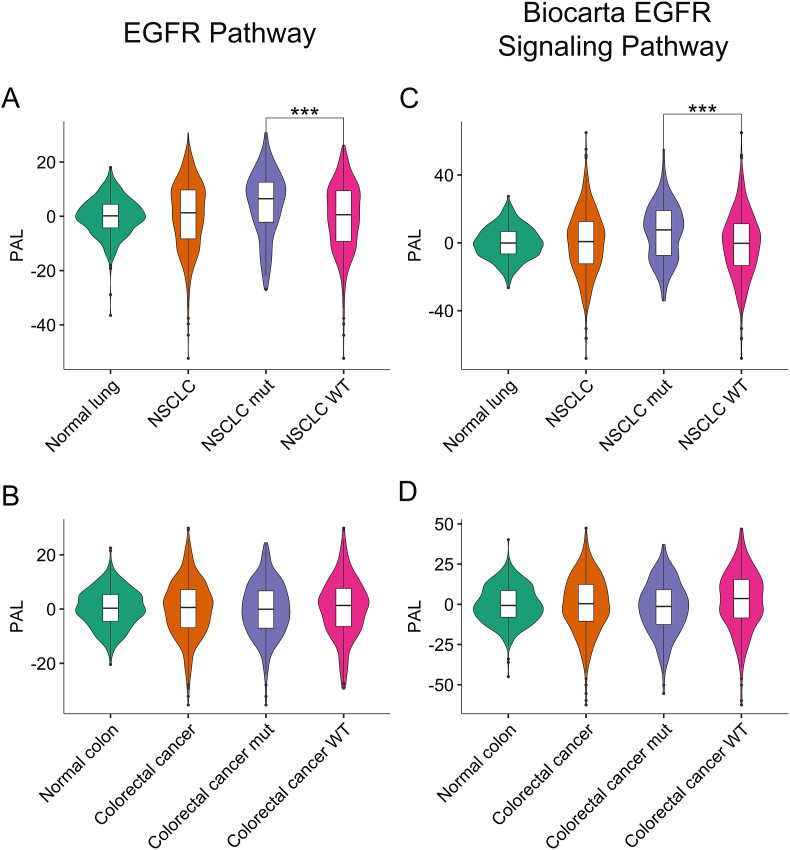
Distributions of pathway activation level (PAL) for the EGFR pathway in cancerous and normal tissues. A-B, distributions for the EGFR pathway (Qiagen Pathway Central) for lung (A) and colon (B) tissues. C-D, distributions for the EGFR pathway (Biocarta) for lung (A) and colon (B) tissues. Cancerous samples were also subdivided into wild type samples (WT) and samples harboring mutations in EGFR, KRAS, NRAS, or BRAF genes (mut).